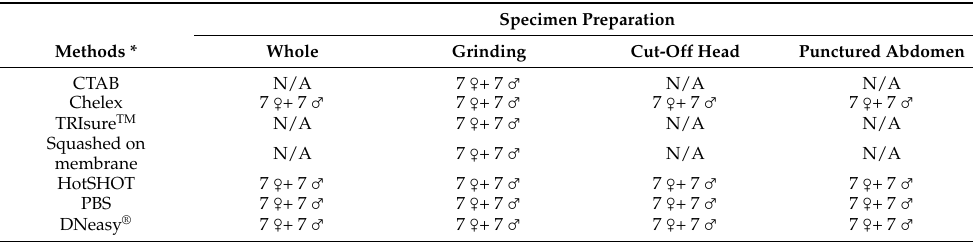
Table 1. Number and sex of B. trigonica specimens used to evaluate each DNA extraction method and preparation